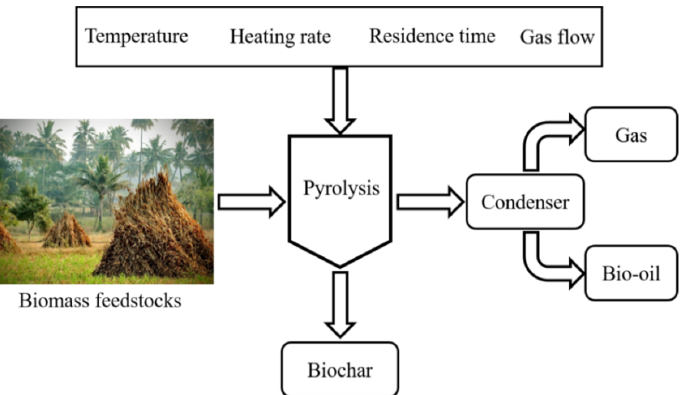
Figure 1. Factors affecting the pyrolysis process of biomass. Recreated with permission from Ref. [55]. Copyright © 2022 Springer Nature.